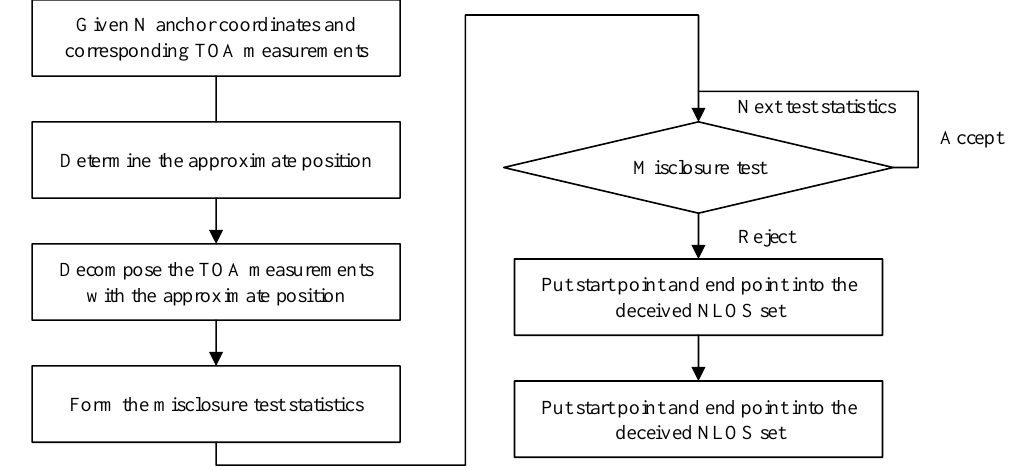
Figure 3. The flow chart of the misclosure check procedure.